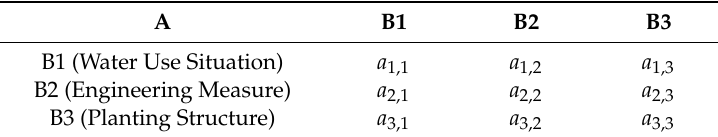
Table 3. A pairwise judgment matrix of the evaluation system.